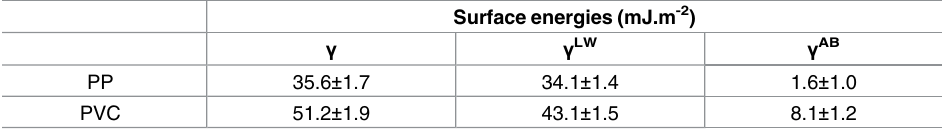
Table 1. Characterization of the two materialsused as substrata: polyvinyl chloride (PVC) and poly- propylene